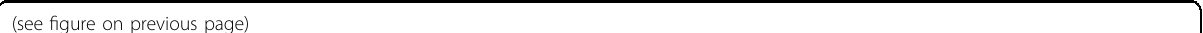
Fig. 1 NP-011 reduces TGF- β 1-induced fi brosis in AOs. A qPCR of the indicated fi brosis-related genes in control AOs and AOs with TGF- β 1 (25 ng/ ml)-induced fi brosis. B Representative images show Sirius red and α -SMA staining of AO sections from the indicated groups. Scale bars, 100 μ m. C , D Western blotting ( C ) and subsequent quanti fi cation of p-ERK, p-SMAD2/3, and Collagen ( D ) in AOs from the indicated groups. Actin was used as a loading control. E qPCR analysis for expression of TGF- β 1 , COL1A1 and IL-11 from the indicated groups. F Western blot analysis for p-ERK in human pAECs incubated with TGF- β 1 (25 ng/ml) or TGF- β 1 and NP-011 (500 ng/ml) for 72 h. Actin was used as loading control. G FMT assay using pulmonary fi brosis patient-derived fi broblasts. The upper panel shows the overall procedure for FMT assay, and the low panel indicates the quanti fi ed data from high-content analysis (HCA). Left axis and blue dots indicate the percentage of inhibition (PIN) of TGF- β 1-mediated α -SMA expression in patient fi broblasts by NP-011 treatment, and the right axis and orange dots indicate the percentage of remaining cells after NP-011 treatment in patient fi broblast. Data are presented as means ± SD from three independent experiments. * p < 0.05, ** p < 0.01